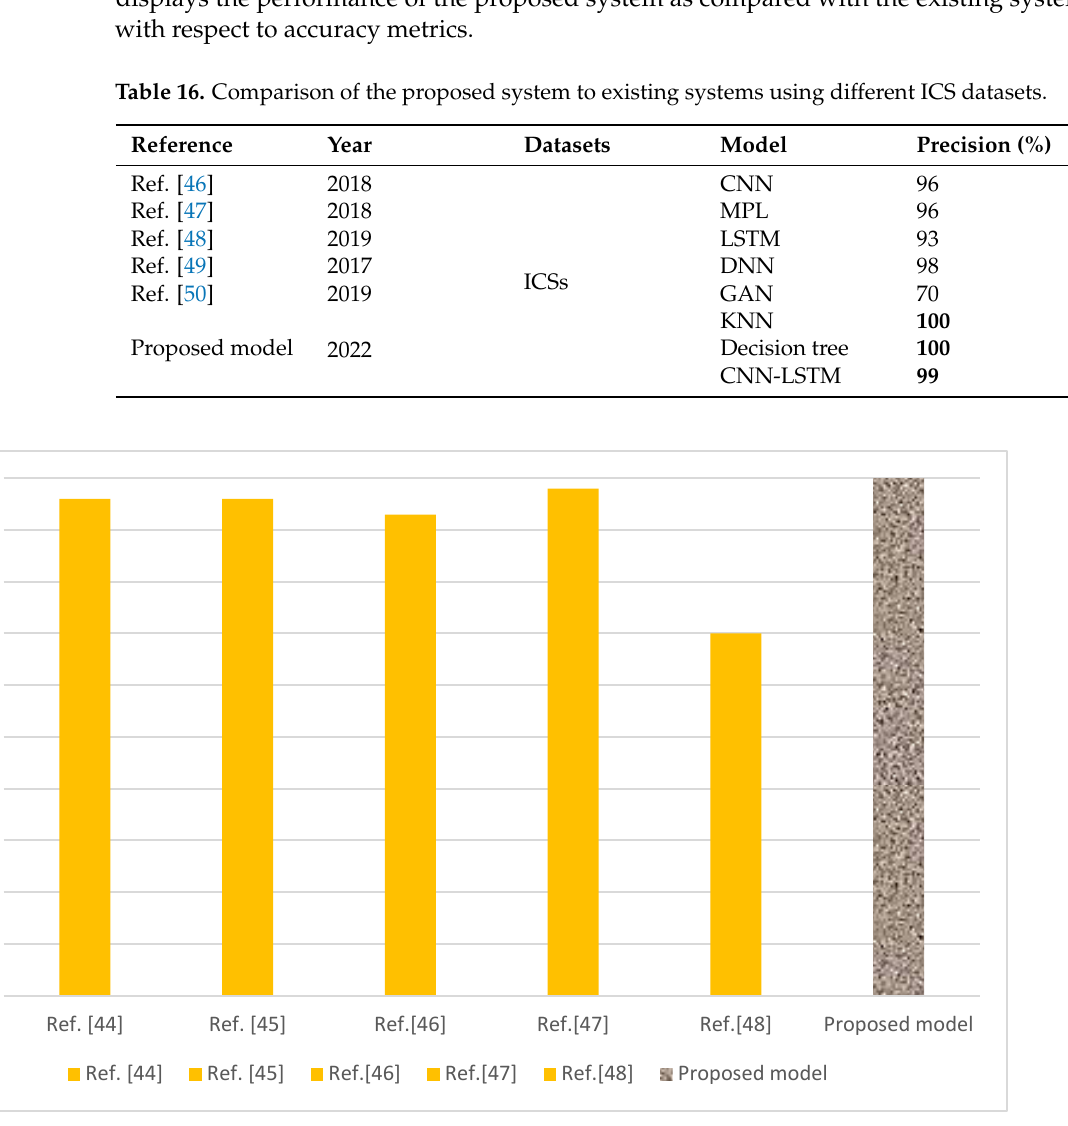
Figure 16. Comparative results of the proposed system with systems using different ICS datasets.